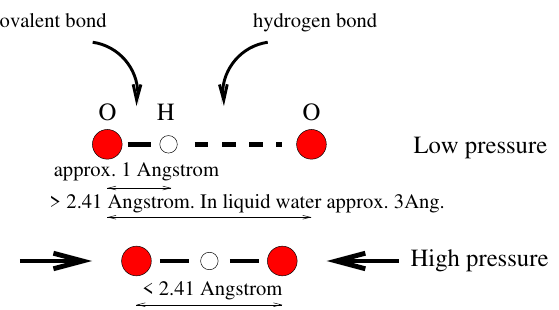
Figure 4. Transition mechanism in ice from a quantum view- point: the horizontal lines (colors correspond to the potential en- Figure 2. Location of the hydrogen atoms between oxygen ergy curve at the same pressure) represent the minimum energy atoms in an asymmetric position for ice VII at low pressure (top) for each pressure increased with the zero-point energy showing and in a symmetric position for ice X at high pressure (bottom) how the e ↵ ective barrier is decreased, which allows the transition < 2 . 41Å. when the oxygen atoms are pushed closer with d O at a lower pressure than in the classical case (figure − O